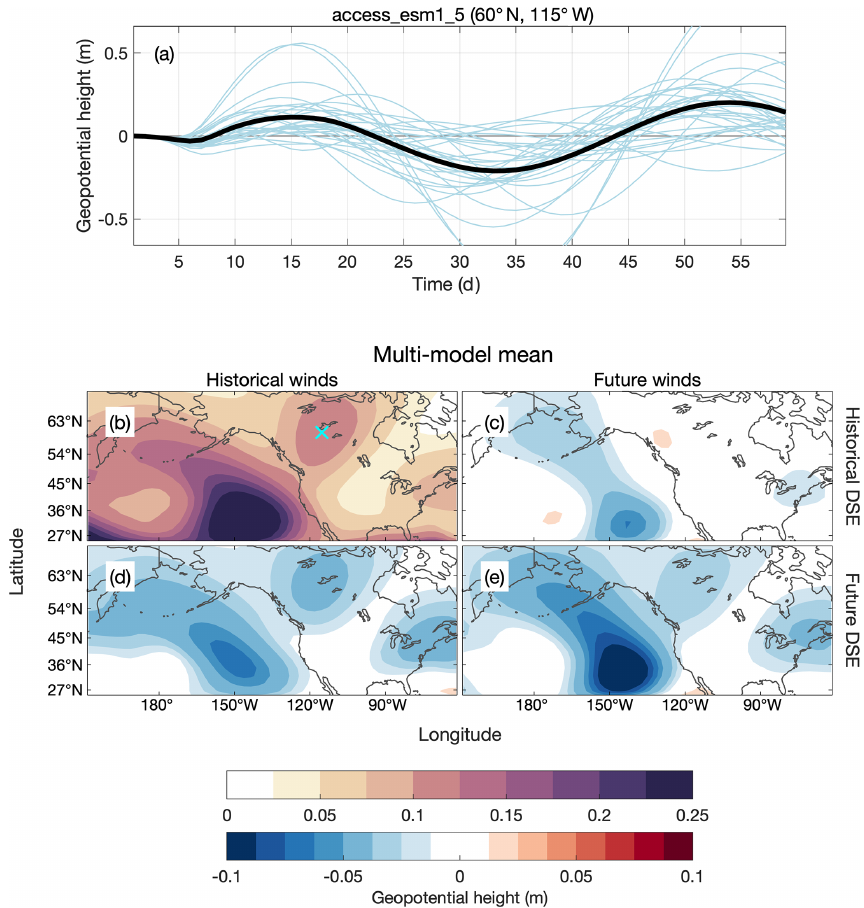
Figure 2. (a) The time series of geopotential height at 500hPa at 60 ◦ N, 115 ◦ W for each January and their mean (thick black line) for the set of LBM simulations with the historical mean state winds and dry static energy (DSE) from ACCESS-ESM1-5. (b) The multi-model mean teleconnection amplitude (see text for definition) for the set of simulations with mean states given by historical winds and DSE. (c) The difference between the multi-model mean teleconnection amplitudes for the set of simulations with the full historical mean state and the set of simulations with future winds and historical dry static energy, (d) historical winds and future fry static energy, and (e) future winds and future dry static energy. DSE indicates dry static